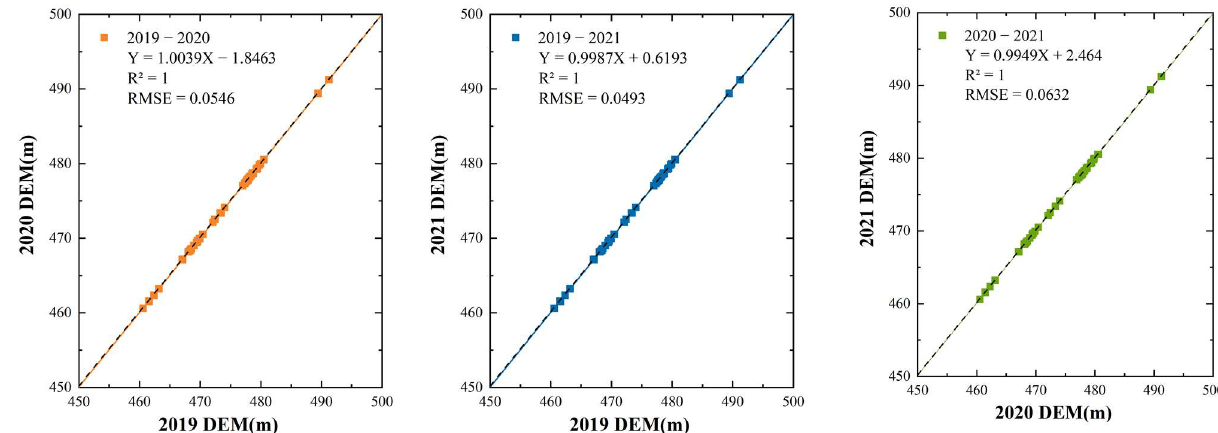
Figure 4. Fitting effect of DEM from different temporal UAV images.